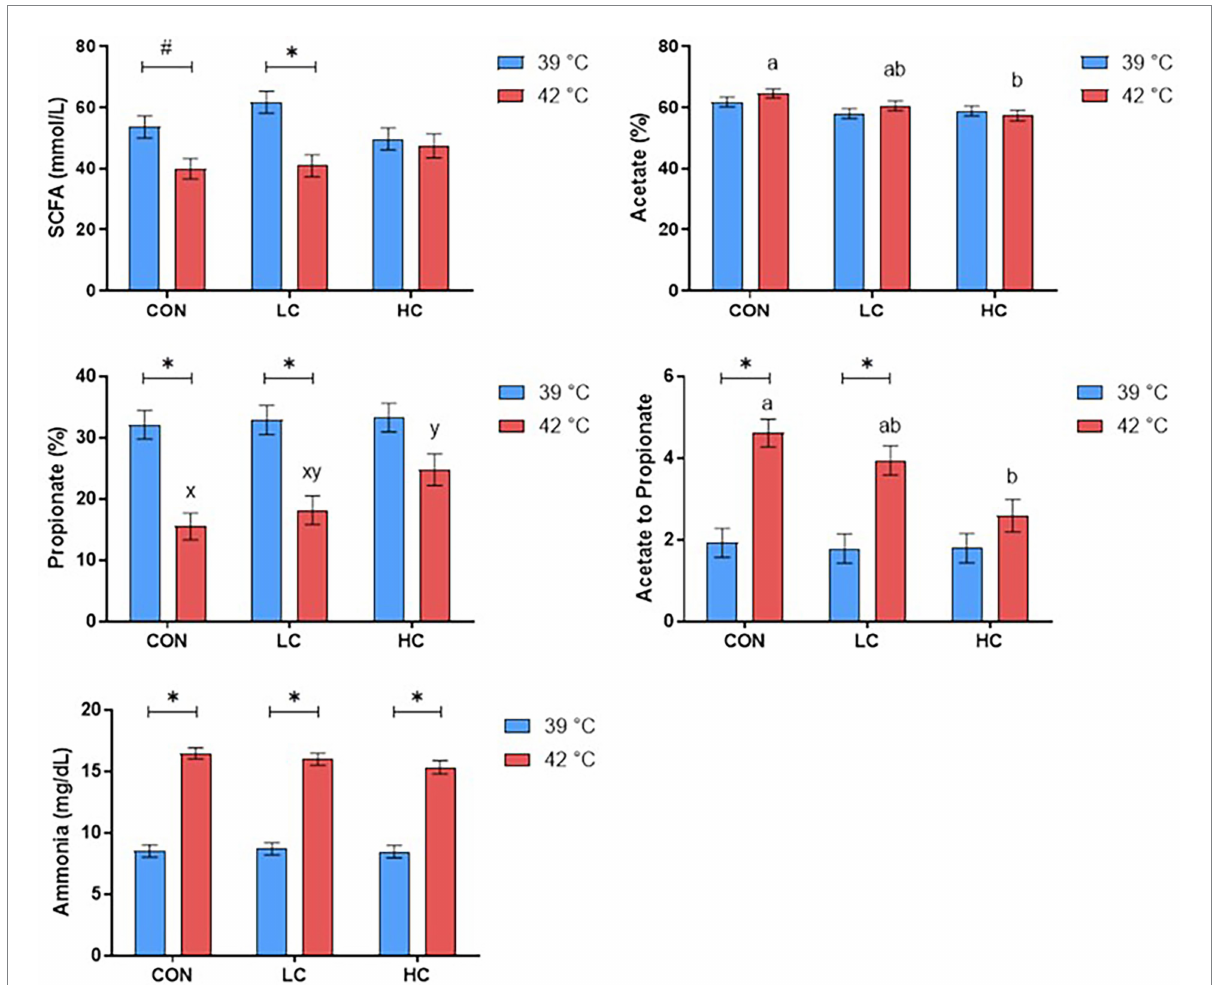
FIGURE 1 Concentrations of short-chain fatty acids (SCFA) and ammonia were affected by capsicum oleoresin (CAP) supplementation and incubation temperature. Least-square means of CAP groups within each temperature sharing no common letter differ at p ≤ 0.05 (a, b) or 0.05 < p ≤ 0.10 (x, y). Differences between the diet within each CAP group ( p ≤ 0.05) ( * ) or 0.05 < p ≤ 0.10 (#). CAP levels: CON: 0 mg/L; LC: 20 mg/L; and HC: 200